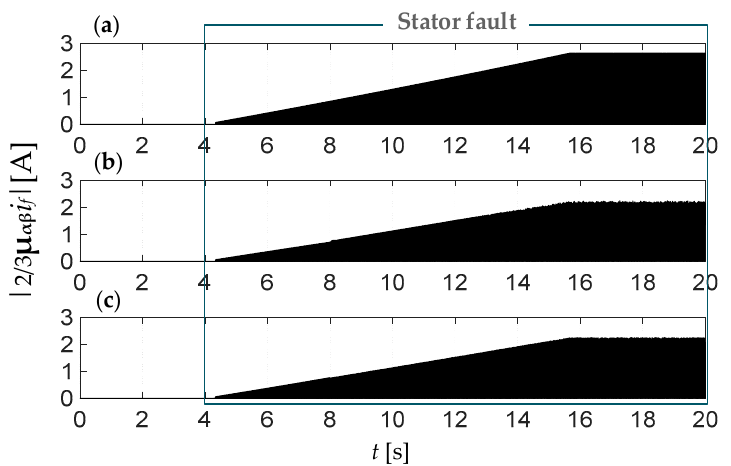
Figure 12. Modulus of the fault factor during ITSC: ( a ) v / f control structure (with the MVM and MCM), ( b ) DFOC control structure with the MVM, ( c ) DFOC control structure with the MCM.